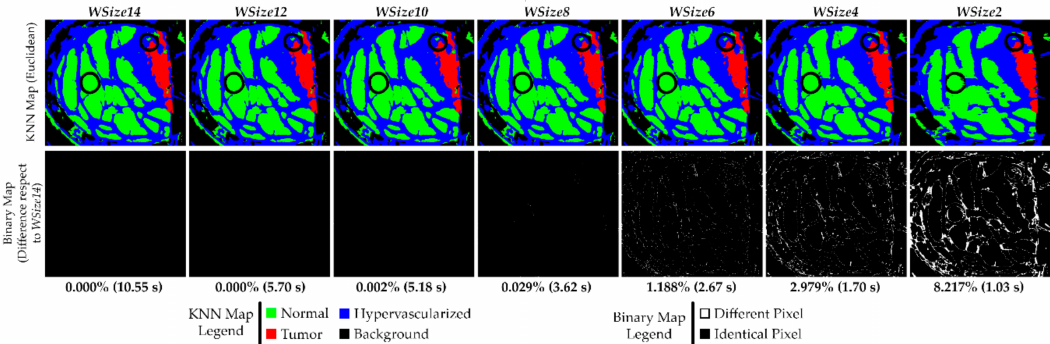
Figure 10. Results of the KNN filtering algorithm obtained from the P2C1 image using the Euclidean distance. The first row shows the filtered classification maps generated using different window sizes. The second row presents the binary maps where the pixel differences between the current generated map and the reference one ( WSize14 ) are shown . In addition, the percentage of differences and the execution time results are